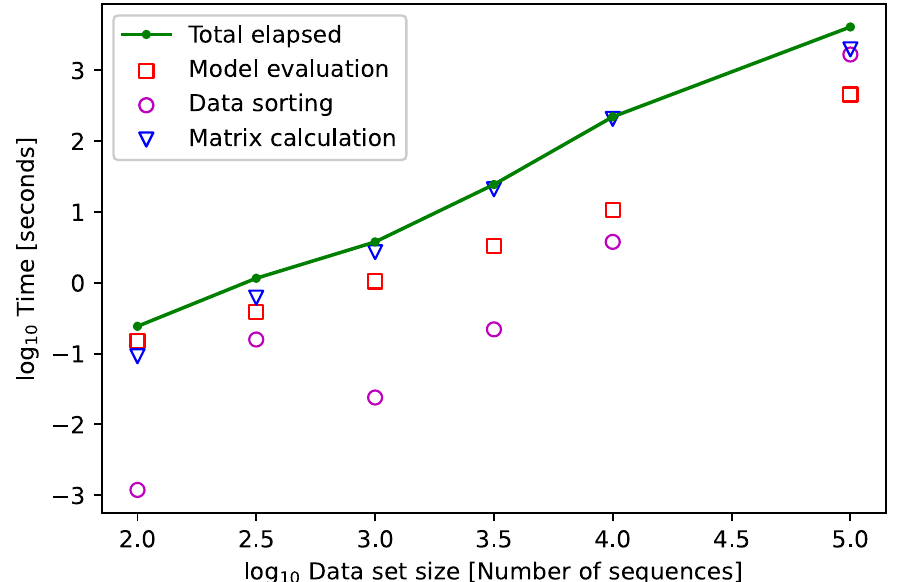
Fig 8. Decomposition of measured total method runtime into the primary components of distance matrix construction, distance matrix sorting, and model evaluation. Measured time performance averaged then log transformed. Less than 100 sequences can be analyzed in under 1